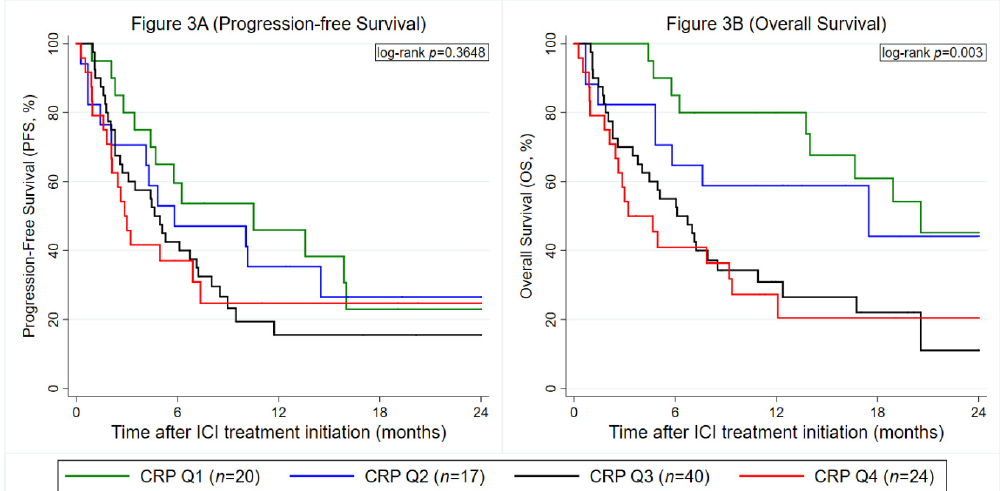
Figure 3. External validation of the prognostic association between baseline CRP levels and ICI treatment outcomes in the Nuremberg cohort ( n = 101). ( A ) Progression-Free Survival. ( B ) Overall Survival. Data are only for patients with observed baseline CRP. Curves were estimated with Kaplan– Meier estimators. The left panel (Figure 2A) depicts a PFS analysis and the right panel (Figure 2B) an OS analysis, respectively. CRP cutoffs were taken from the Graz cohort and were as follows: Q1: CRP ≤ 7.7 mg/L, Q2: CRP > 7.7 mg/L, but ≤ 21.6 mg/L, Q3: CRP > 21.6 mg/L, but ≤ 66.1 mg/L and Q4: CRP > 66.1 mg/L. Abbreviations: PFS—progression-free survival; OS—overall survival; CRP—C-reactive protein; Q—quartile; ICI—immune checkpoint inhibitor.